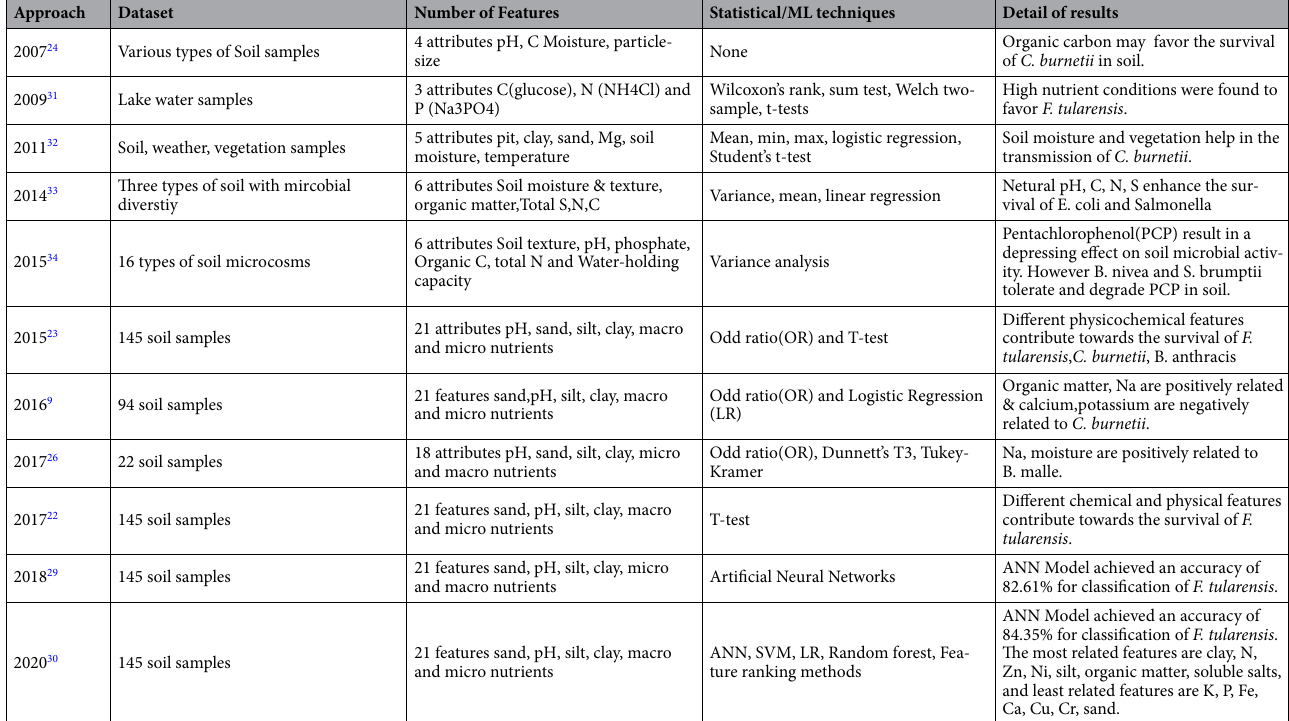
Table 1. A comparison of Statistical and Machine learning techniques applied to assess the contribution of environmental features for the prevalence of